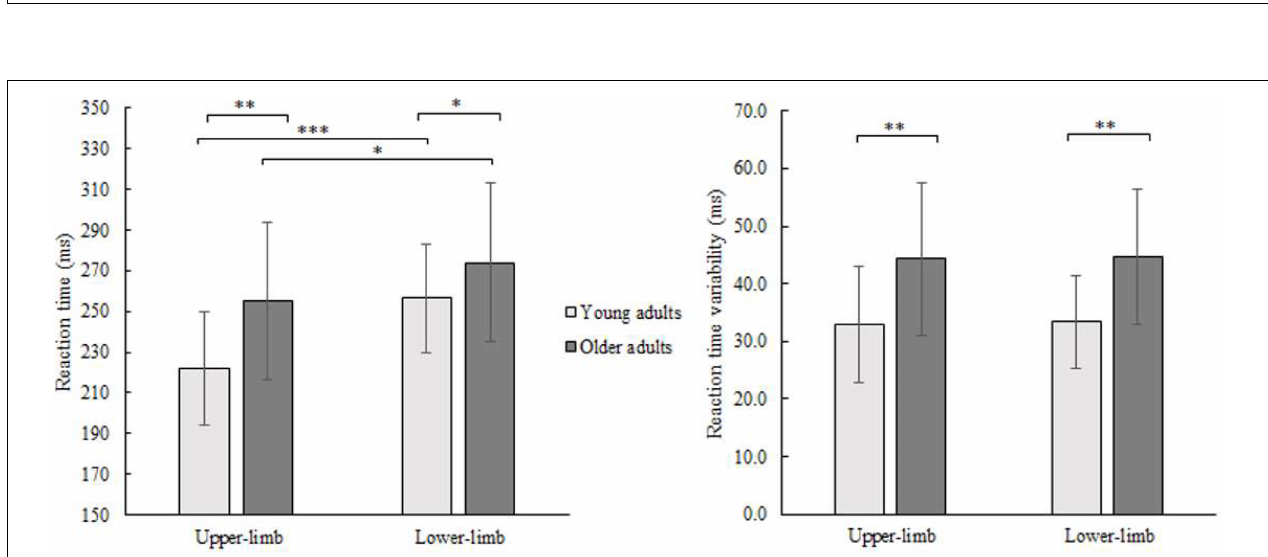
FIGURE 2 | Mean RT (left) and its variability (SD) (right) of younger and older adults for lower- and upper-limb conditions. Error bars reflect one SD. ∗ represents p < 0.05; ∗∗ represents p < 0.01; ∗∗∗ represents p < 0.001.